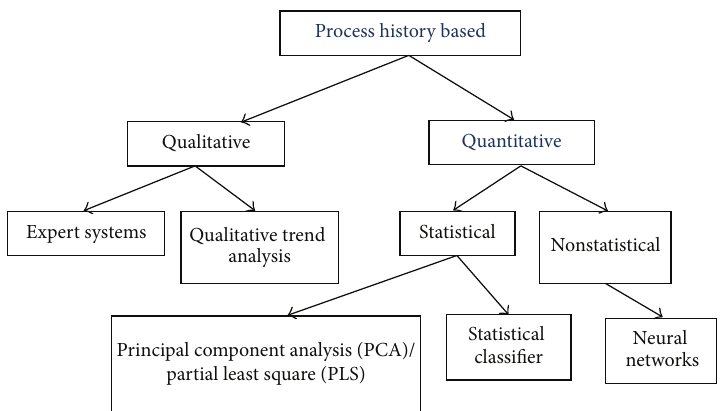
Figure 3: Classification of process history-based methods (redrawn from